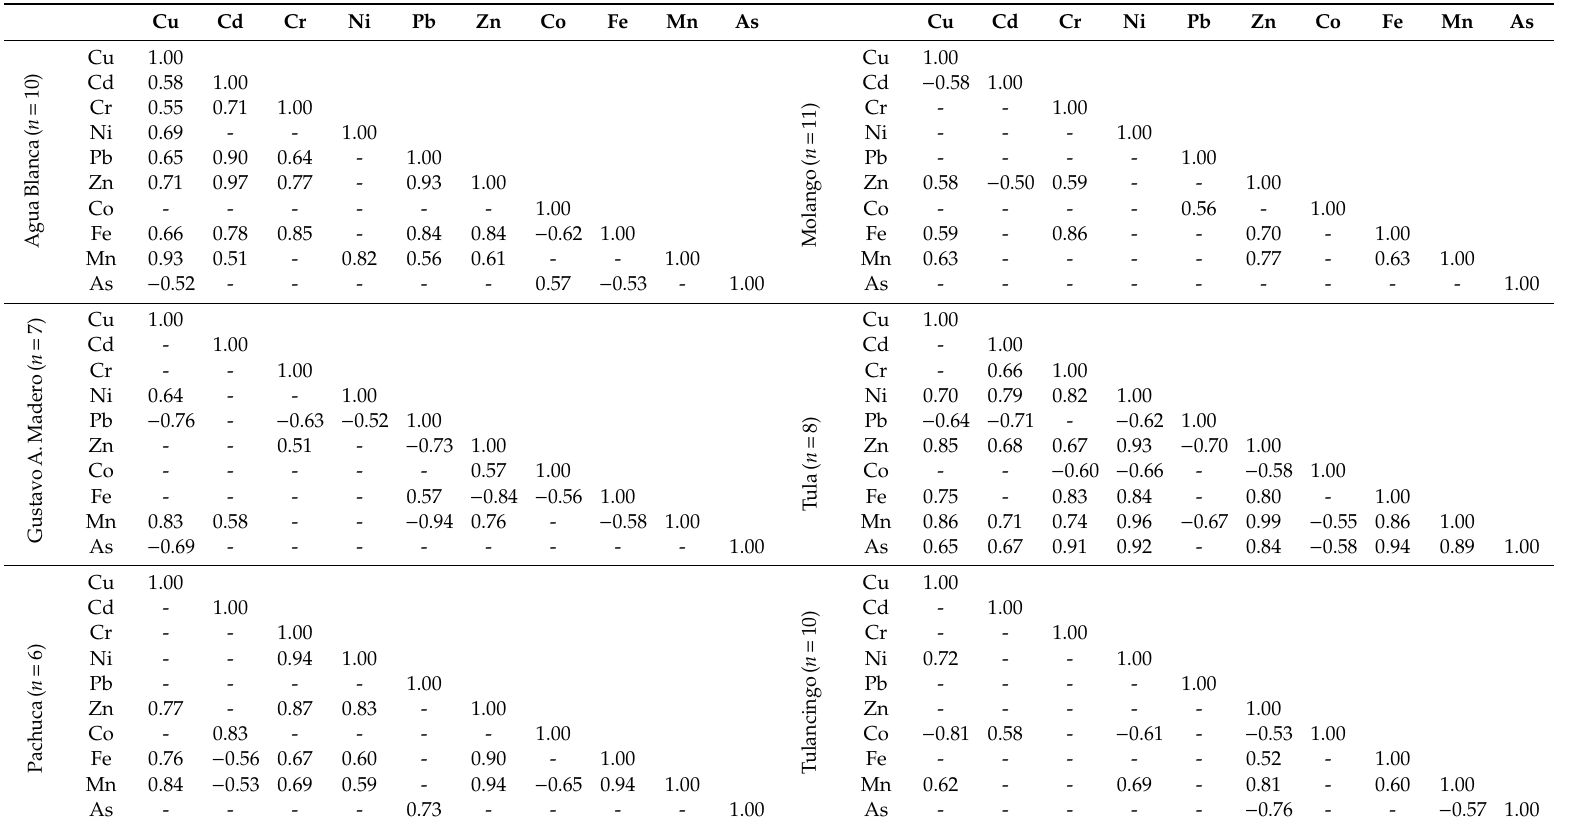
Table 4. Correlation matrix values of six studies sites from Central